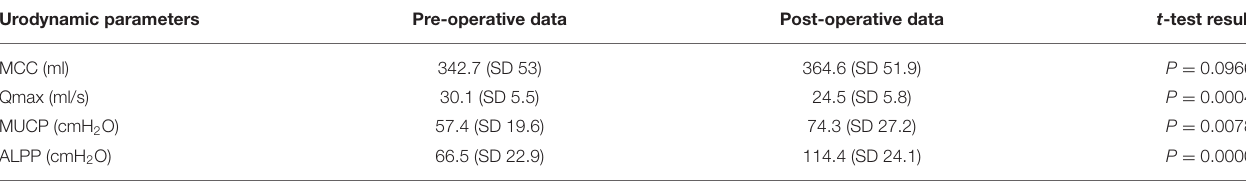
TABLE 3 | Six-month follow-up urodynamic study results.